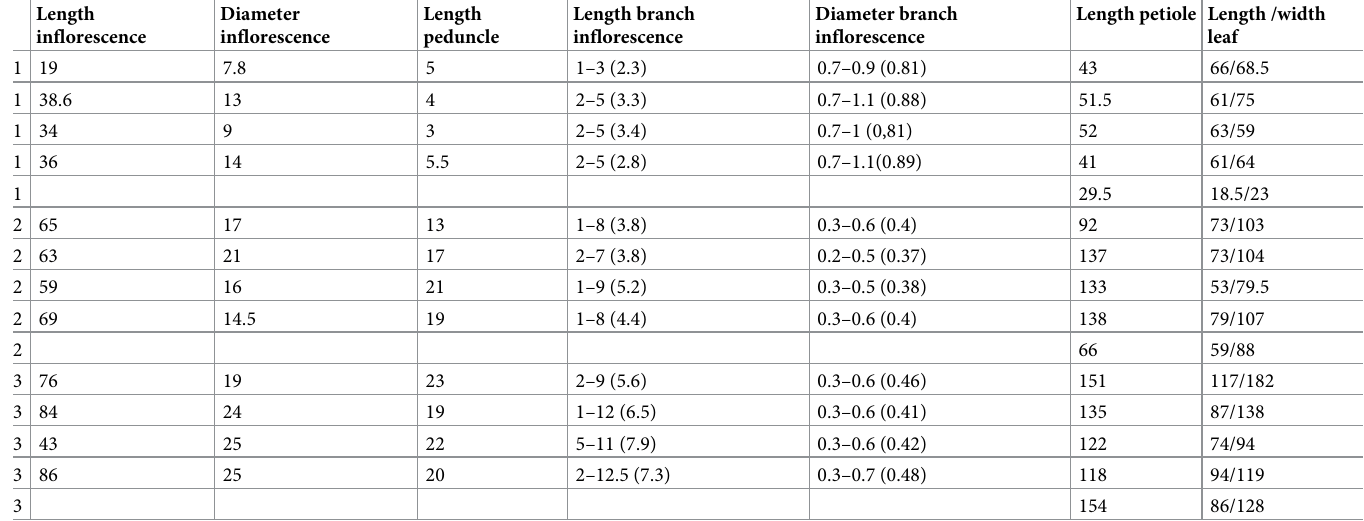
Table 3. Morphology of living plants at the Hortus Botanicus Leiden; one plant of G . tinctoria (1), and two plants of “ G . manicata ” (2, 3). Each plant 5 leaves and 4 inflorescences, 10 branches of each inflorescence at midsection of inflorescence. Length inflorescence